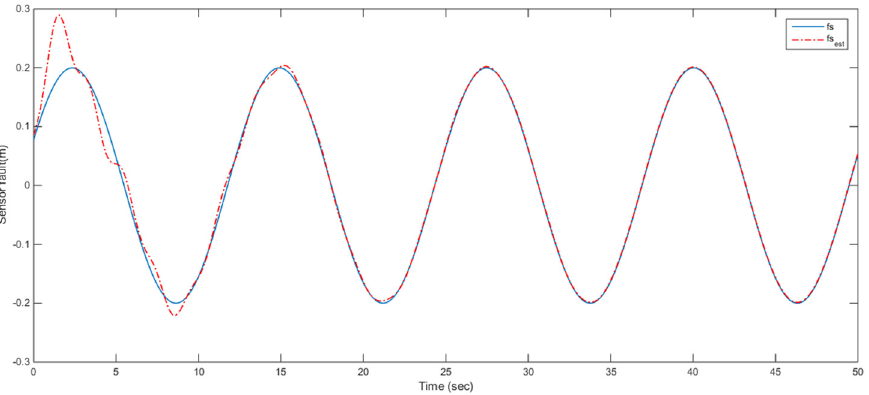
Figure 6. The proposed sensor fault and its estimation.